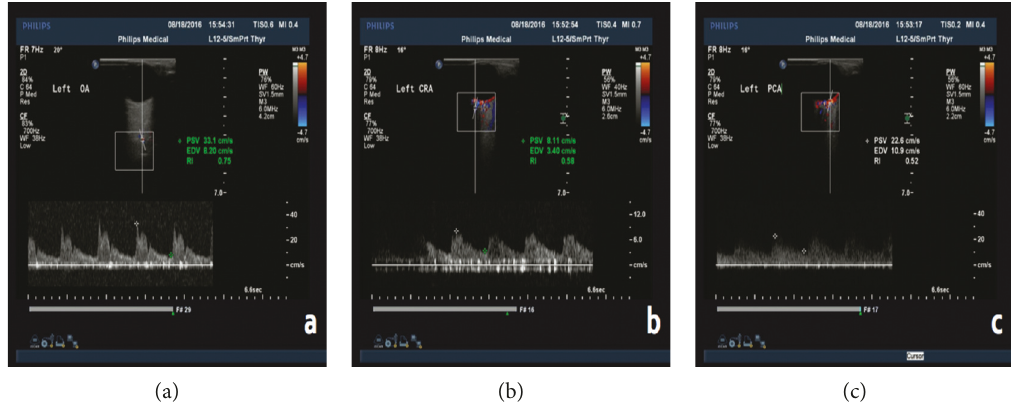
Figure 2: Ultrasound Doppler examinations of major ocular vessels and the measurement process of major vascular parameters. The parameters: peak systolic velocity (PSV), end diastolic velocity (EDV), and resistance indices (RI). (a) The measurement processes of the ophthalmic artery (OA): peak systolic velocity (PSV), end diastolic velocity (EDV), and resistance indices (RI). (b) The measurement processes of the central retinal artery: peak systolic velocity (PSV), end diastolic velocity (EDV), and resistance indices (RI). (c) The measurement processes of the posterior ciliary artery: peak systolic velocity (PSV), end diastolic velocity (EDV), and resistance indices